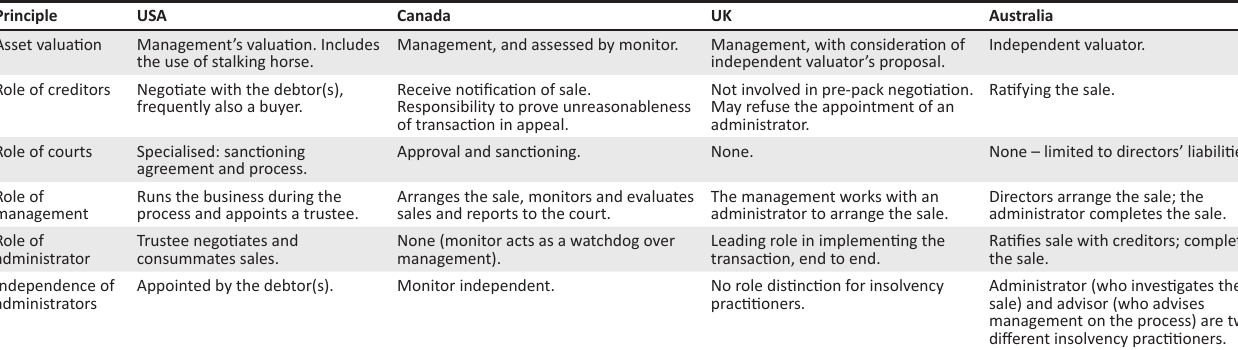
TABLE 1: Bidding principles in international pre-packs.